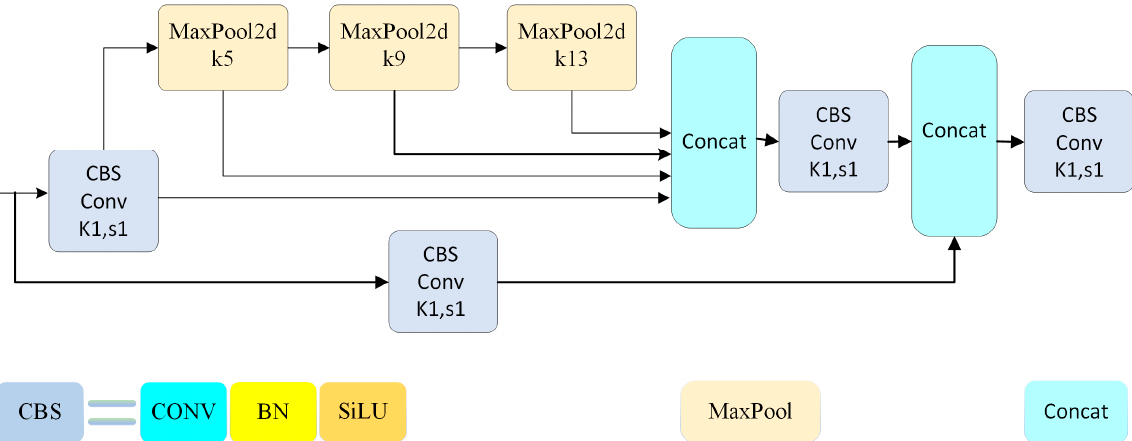
Figure 1. SPPFCSP network structure.